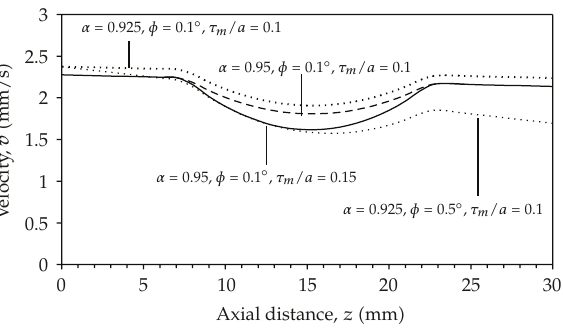
Figure 4: Velocity distribution in the axial direction for di ff erent values of φ , τ m /a , and α with t (cid:7) 0.5 , τ y (cid:7) 0.1, μ H (cid:7) 0.035, and μ N (cid:7) 0.3 μ H .